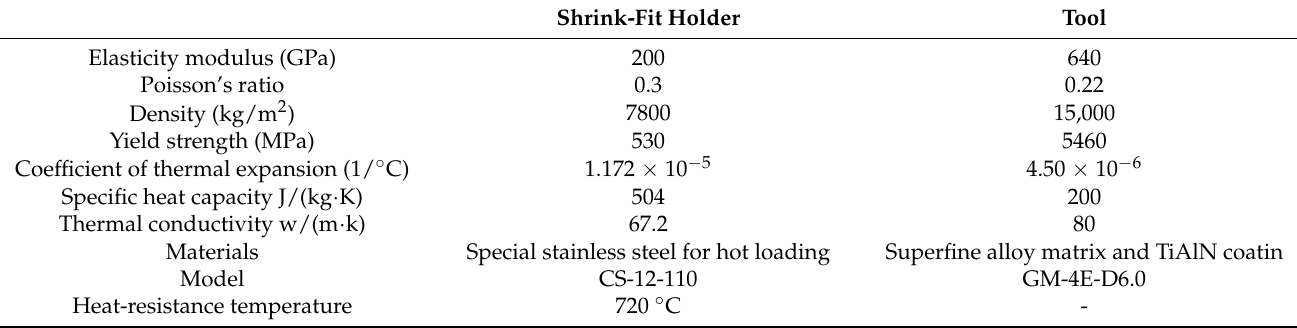
Figure 2. Finite element model of the shrink-fit holder and tool. Table 1. Parameters of the shrink-fit holder the tool.